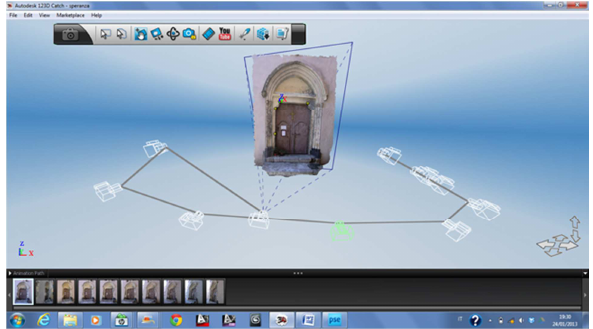
Figure 3. Cagliari, La Speranza. Screenshot of 123D Catch The total time, necessary to obtain the product of the combination of the photos, depends on the speed of connection available. The connection rate determines, in fact, the loading